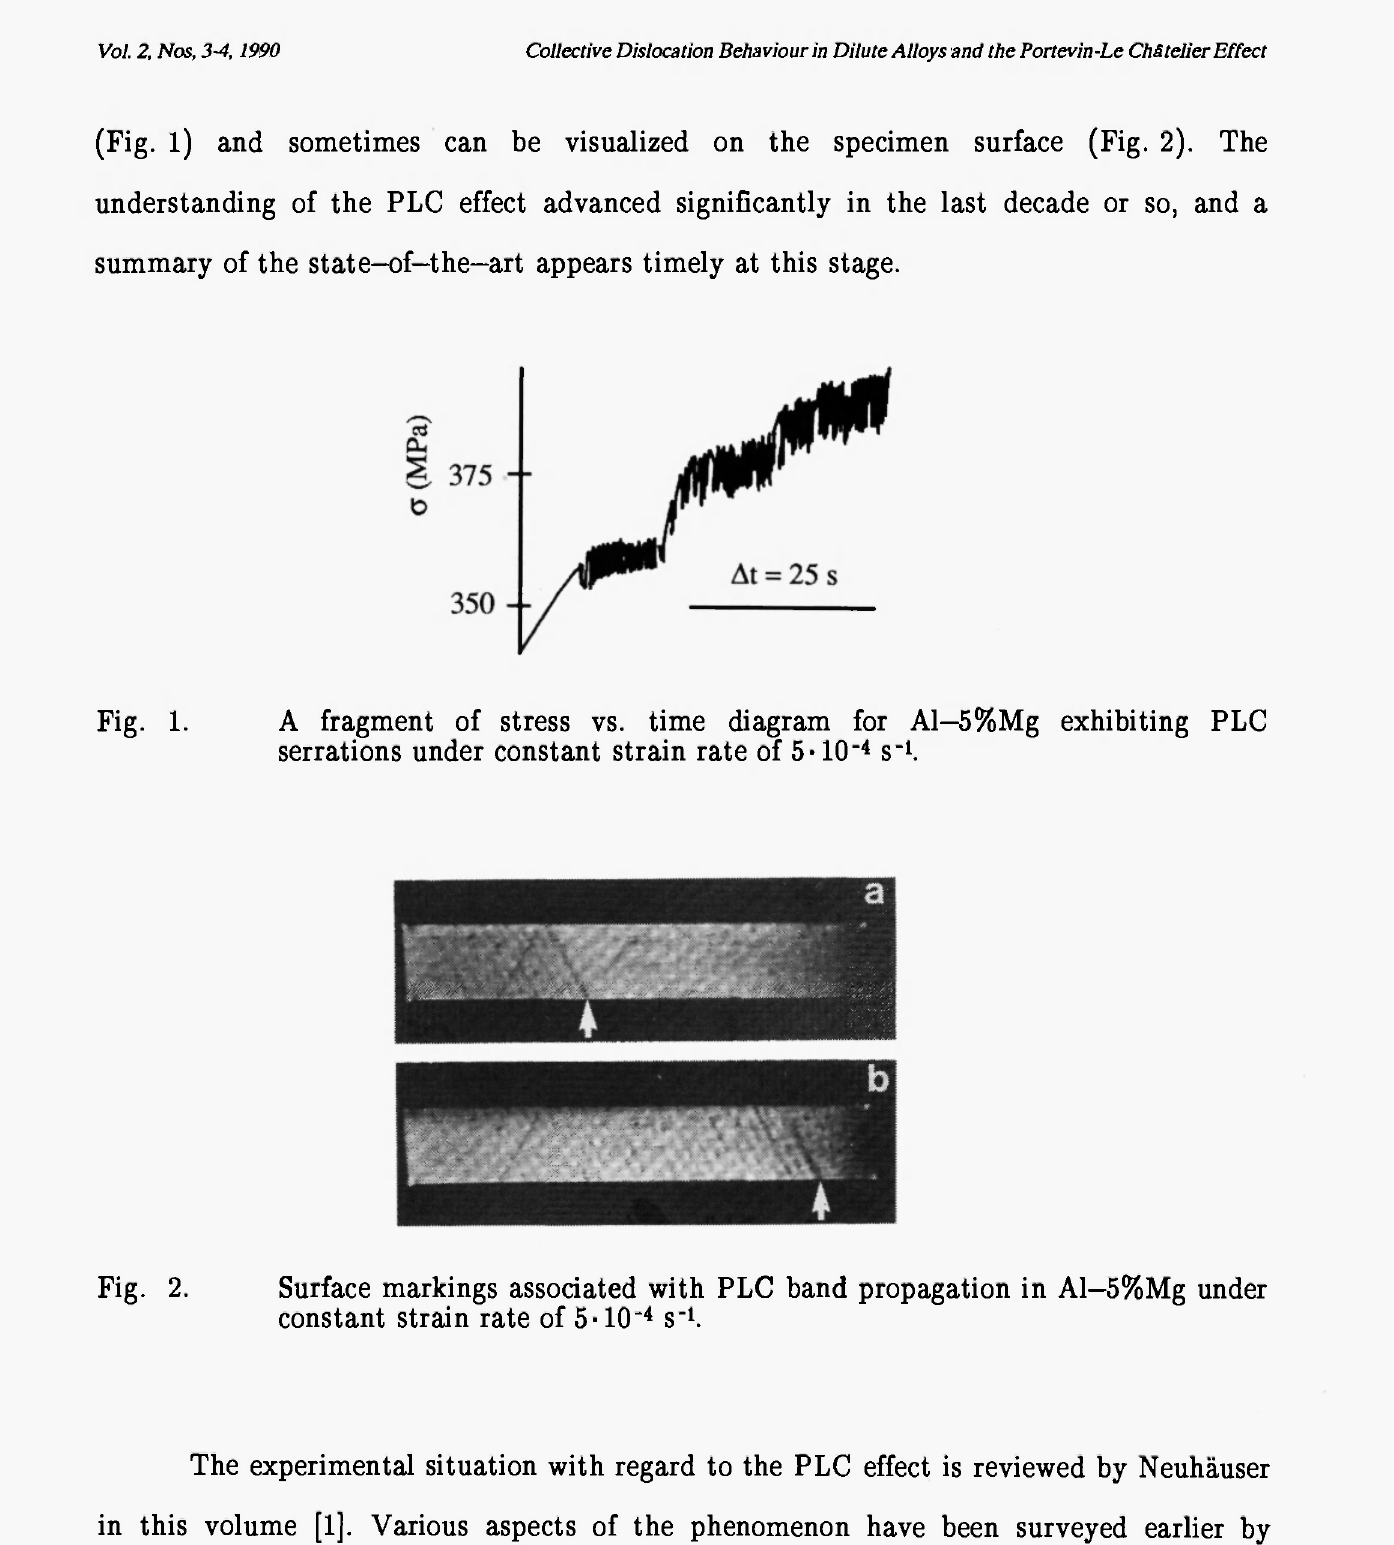
Fig. 2. Surface markings associated with PLC band propagation in Al—5%Mg under constant strain rate of 5-10 ~ 4 s" 1